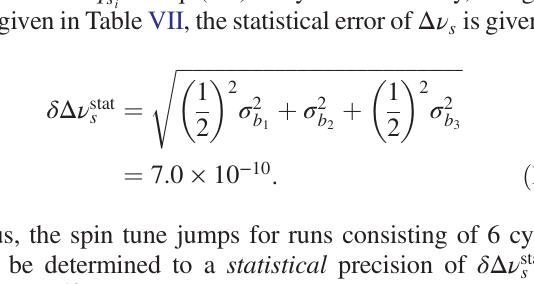
FIG. 14. Distribution of the statistical errors σ the linear parameters b 1 , b 2 , and b 3 of Eq. (D3). The mean values of statistical errors are listed in Table VII.